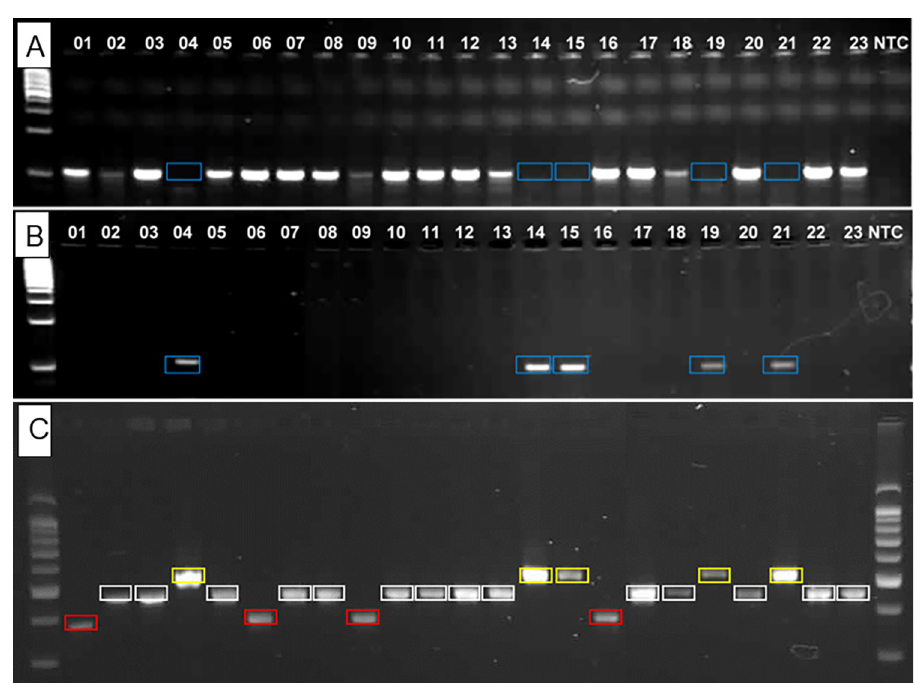
Fig 2. Representative SNP (MAMA) and INDEL assay results with 23 R . typhi DNAs. DNA numbers are listed in Table 1. The SNP assay for site 2_081 is shown with 2 selective primer sets for each polymorphism (A and B). Blue boxes in Panel A show no amplicons for this nucleotide type, and are the only amplicons produced in Panel B for the alternative nucleotide type. The INDEL assay (Panel C) for site i5_351 reveals 3 product sizes; yellow boxes 517 bp, while boxes 442 bp, and red boxes 367